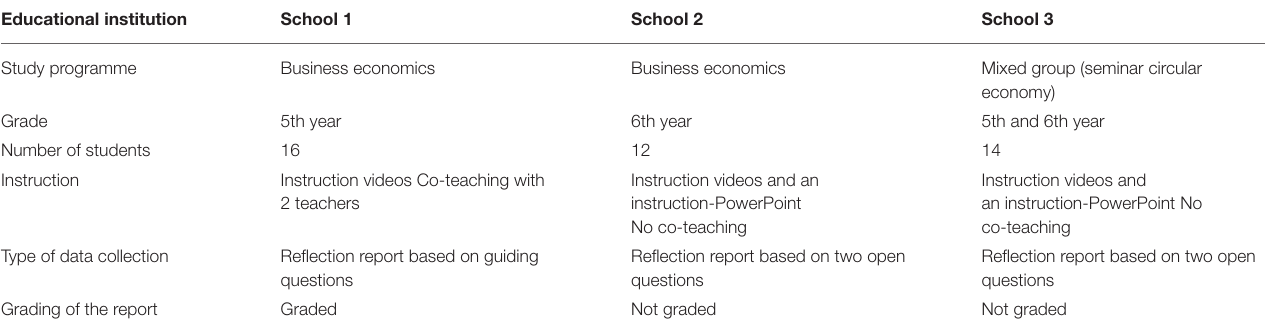
TABLE 4 | Information class